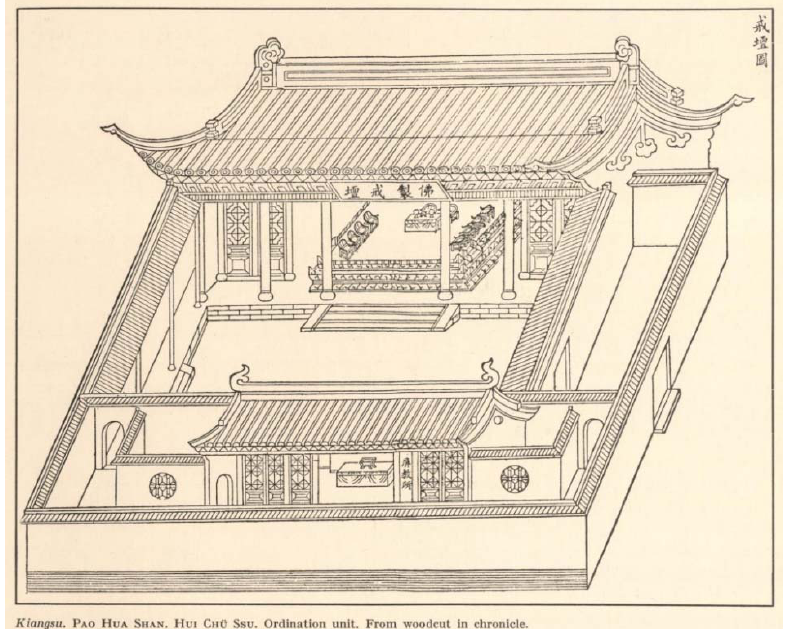
Figure 13. The Picture of the Ordination Platform Unit. Chinese, wood ‐ block print, book illustration, the eighteenth century (Prip ‐ Møller 1937, p. 297; BHSZ [1795] 1975, vols. 1, 6).